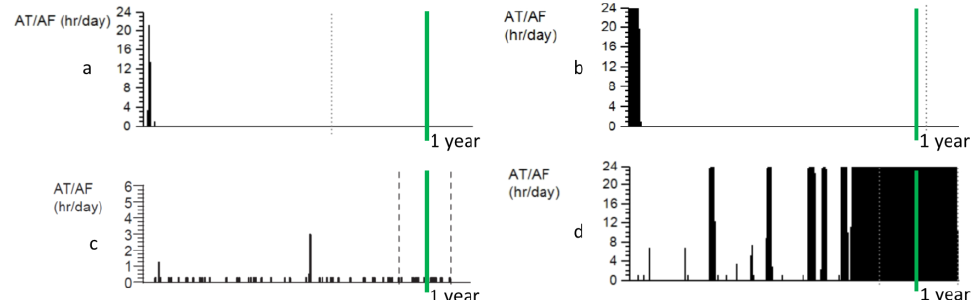
Figure 5. Examples of the clinical course of AF in patients with implanted dual chamber cardiac pacemakers or defibrillators. These devices provide the capability of continuous heart rhythm monitoring after implant. Pacing provides treatment for symptomatic bradycardia and may also enable the use of medical or non-pharmacological treatment for AF if a low heart rate was limiting their use prior to the device implant. One-year follow-up is marked with the green line. Daily AF burden varies from 0 to 24 h. ( a ) Remission of paroxysmal atrial fibrillation a few weeks after device implant. ( b ) The pacemaker was implanted in a patient with persistent atrial fibrillation. Cardioversion was performed several weeks after the implant, and the AF remained in remission thereafter. ( c ) Paroxysmal atrial fibrillation with a stable burden after implant. ( d ) Progression of paroxysmal AF into persistent